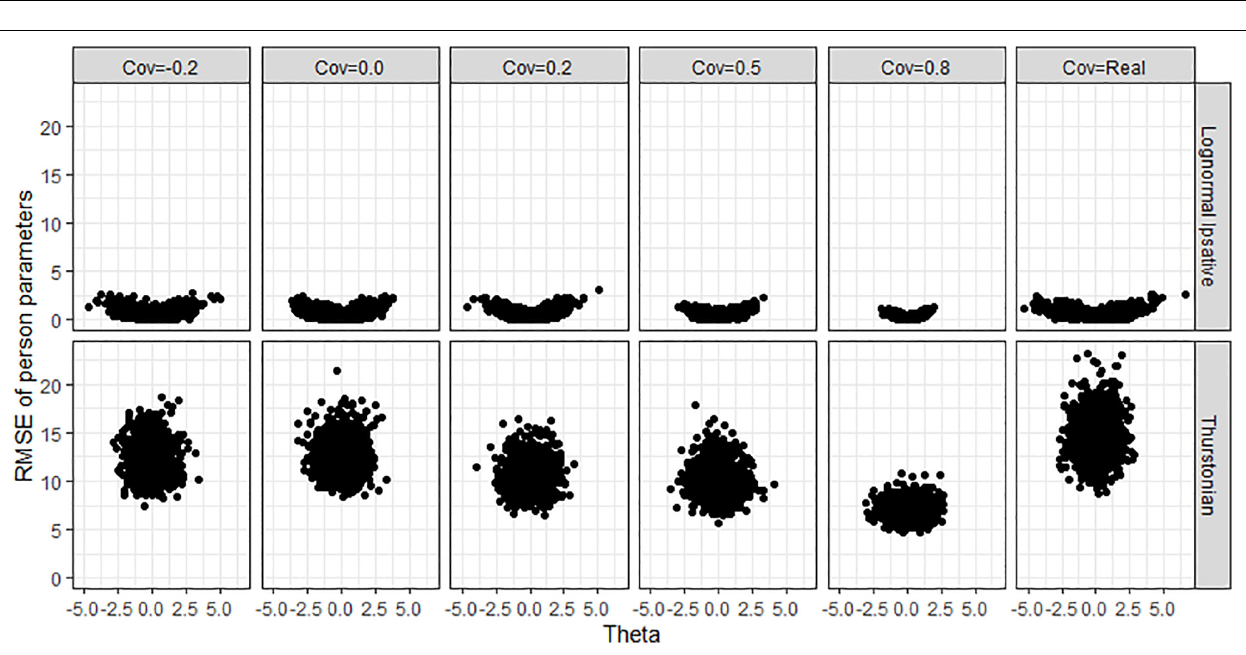
FIGURE 11 | RMSE of person parameters obtained by fitting the lognormal ipsative model and the Thurstonian model to simulated data. RMSE is root mean square errors. Cov = the covariance between latent trait. Cov = Real indicates the variance-covariance matrix followed the empirical result in literature.